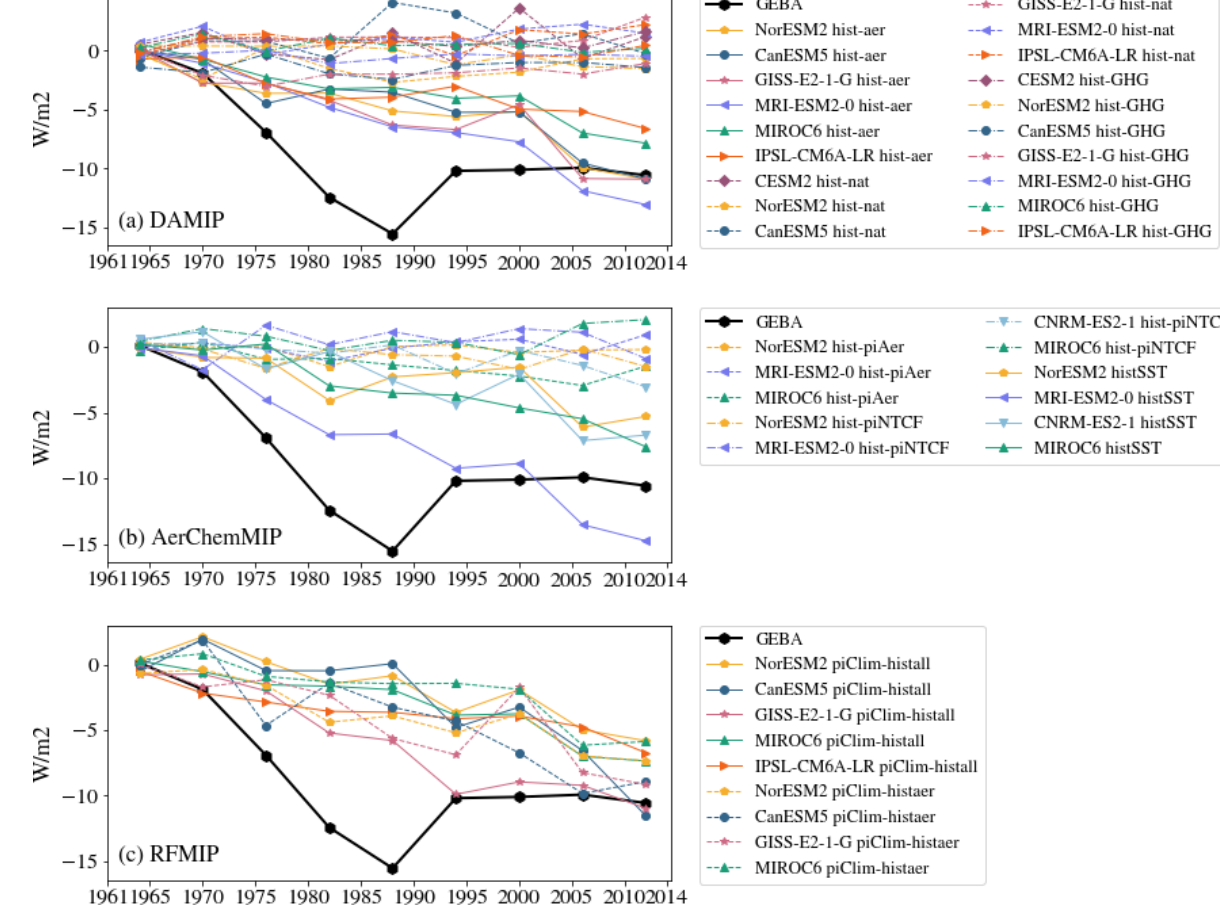
Figure 3. SDSR anomaly in China for all the CMIP6 simulations as listed in Table 1. All model results are co-located at GEBA station locations registered to China (119 stations). The entire 54-year period has been divided into intervals of 6 years and then averaged together to make nine data points as shown by the